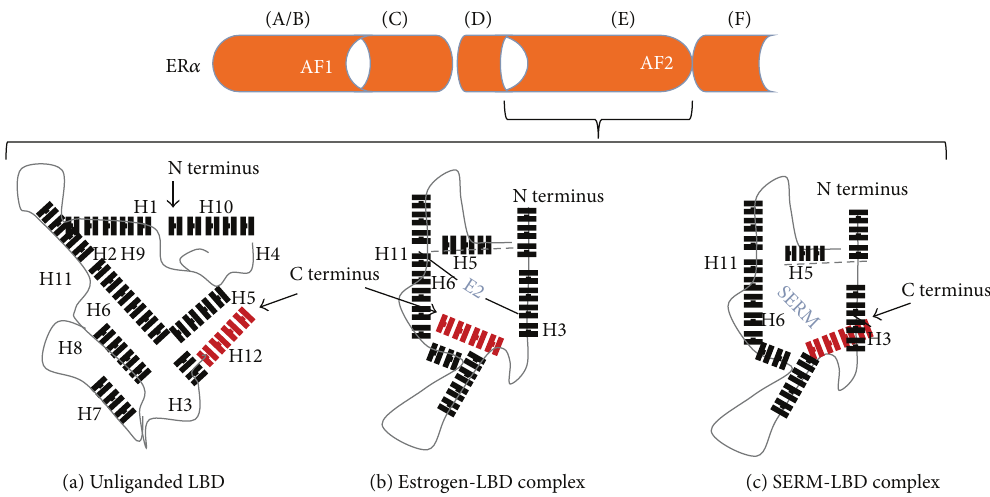
Figure 2: Monomeric modeling of ER 𝛼 LBD. The LBD (a) is a three-dimensional configuration composed of three folded strata. The central core is comprised of helices 5, 6, 9, and 10, which is positioned between two layers, one composed of helices 1–4; the other helices 7, 8, and 11. The size of the binding cavity is approximately two-fold greater than the molecular volume of estradiol. E2 binds diagonally (b) between helices 11, 6, and 3 and induces a conformational change in the LBD. Devoid of contact with the ligand, helix 12 (in red) is repositioned, thus providing a protective seal over the binding cavity. Reorientation of helix 12 in this manner intrinsically generates AF2, recruits coactivators, and promotes transcription. However, when the receptor binds selective estrogen receptor modulator or SERM (c), the length of the SERMs side chain exceeds the confines of the binding cavity. As a result, helix 12 is misaligned over the binding pocket. Diffraction studies indicate helix 12 is rotated 130 ∘ toward the N terminus of the